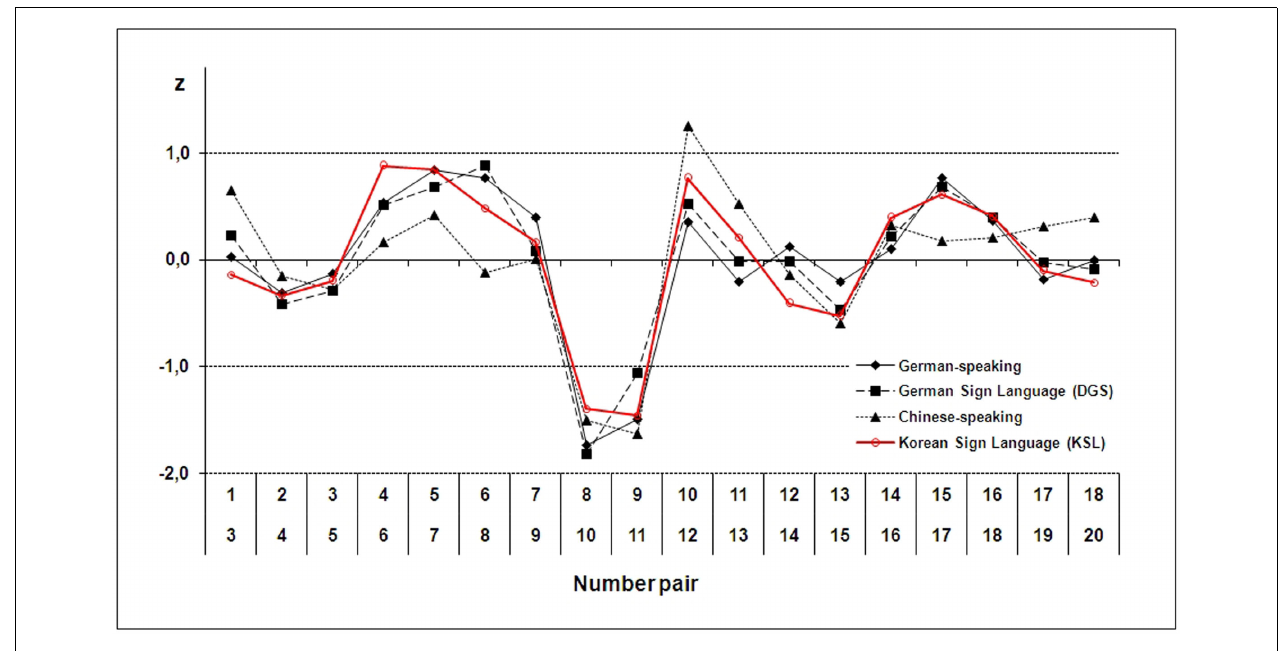
FIGURE 4 | Standardized residuals for Korean deaf signers (red line) and three different participant groups performing the same task. Details on